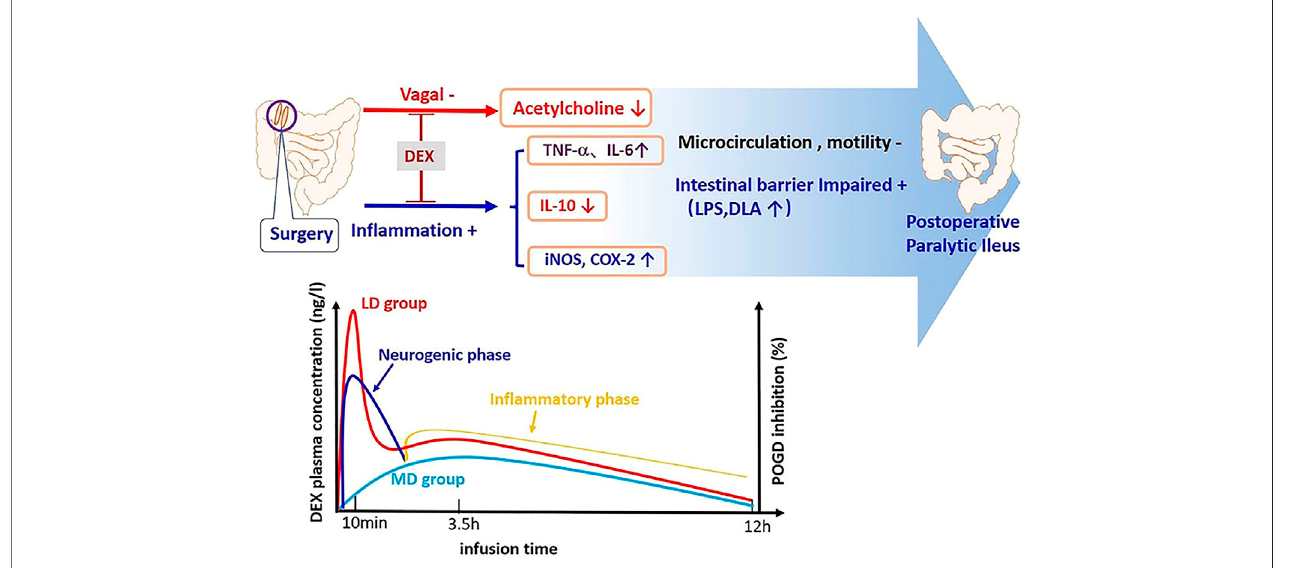
FIGURE5| PathogenesisofPOGDandmechanismofintestinalprotectionbyDex.TherearetwophasesofPOGD:theneurogenicphaseandin fl ammatoryphase. Theextradose ofDexcausedahigher levelofDexplasmaconcentrationfromtheskin incision topostoperative 8 h,and thisperiod oftime isalsothetime forthePOGD development. In the meantime, Dex also induced signi fi cantly higher plasma IL-10, but lower IL-6, TNF- α , COX-2, iNOS, LPS, and DLA.